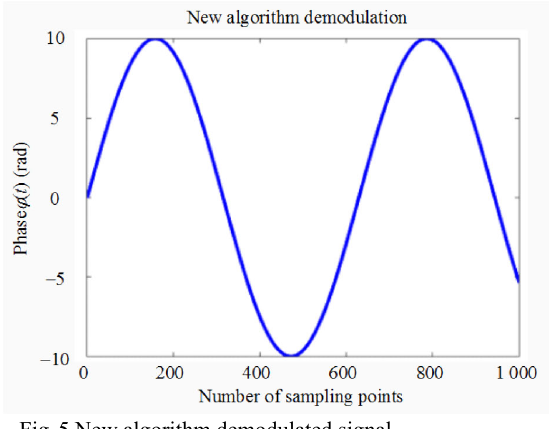
Fig. 5 New algorithm demodulated